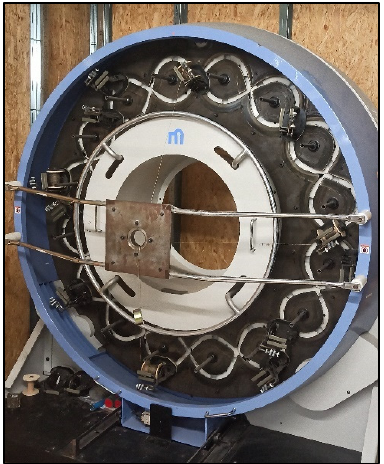
Figure 1. Arrangement of fiber spools on braiding machine.